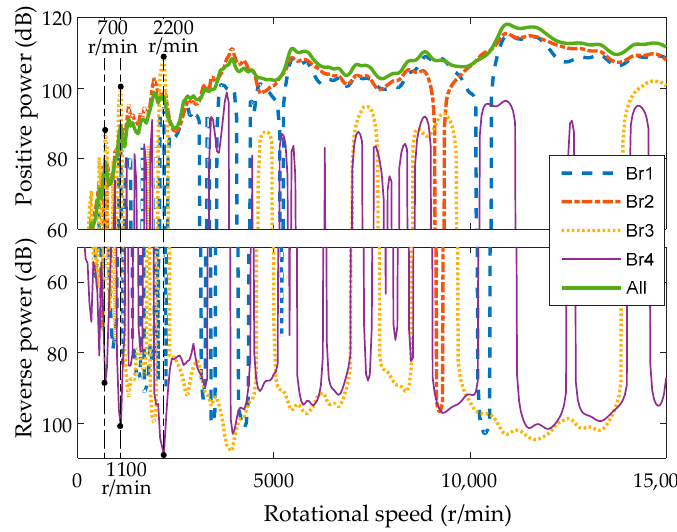
Figure 13. Bearing housing transmitted power—location path. The vibration power of bearing housing corresponding to the direction path is shown in Figure 14. At high speed, the vibration is domain by uy and the vibration power in the uy direction is mainly positive. Ux only contributes to the vibration at some special rotational speed, while the other DOF contribute little to the vibration. At low speed, each DOF contributes to the vibration to a certain extent, and there are reverse power flows at some rotational speeds. There is resonance in the ux direction near 1100 r/min and 2200 r/min. Peak values are 94.6 dB and 102.5 dB, respectively, which are 5.0 dB and 4.8 dB higher than the total vibration power, while there is obvious reverse power in the uy direction, with the amplitudes of 96.1 dB and 103.9 dB, respectively. Relatively speaking, the contribution of roty DOF to vibration is small.